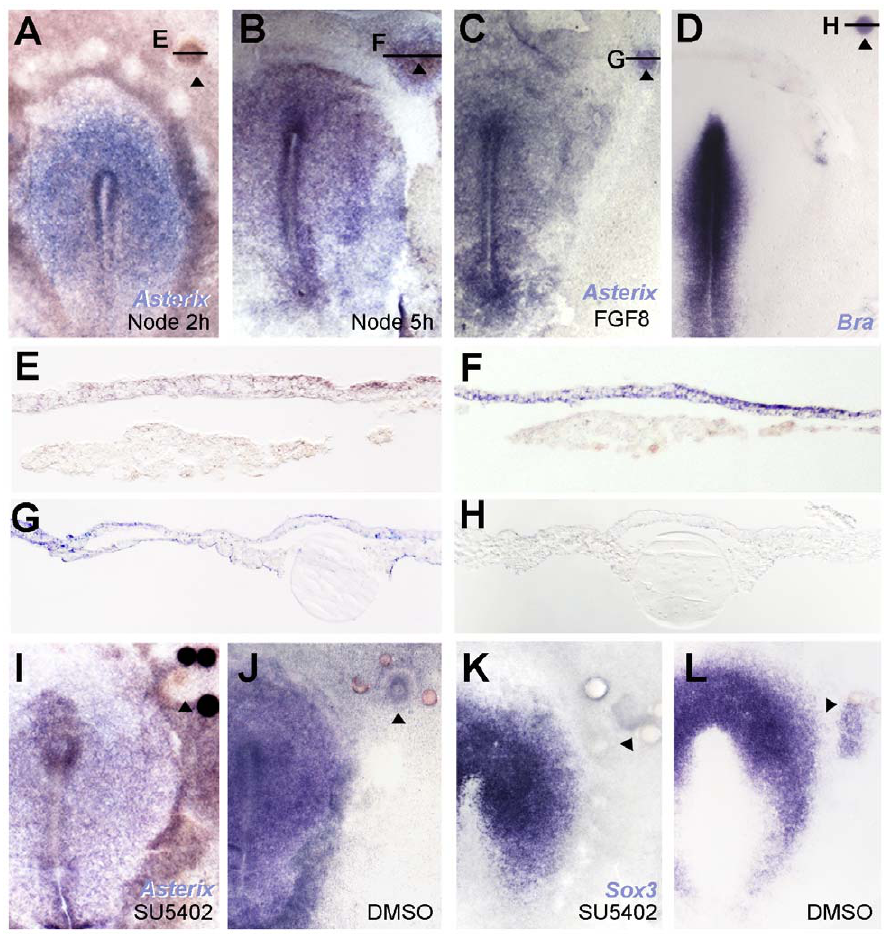
Figure 9. Regulation of Asterix by Hensen’s node and peptide factors. Grafts of Hensen’s node do not induce Asterix after 2 hours (A, E), but do induce it after 5 hours (B, F). This is mimicked by grafts of heparin beads soaked in FGF8, which induce Asterix (C, G) but not Brachyury (D, H). When a node is grafted together with beads soaked in the FGF inhibitor SU5402, Asterix induction is blocked (I), as is induction of the early pre-neural marker Sox3 (K). Grafts of the node together with the vehicle DMSO do not affect induction of either marker (J for Asterix , L for Sox3 ). Note that some probes attach non-specifically to some types of beads and to COS cell pellets (eg. panels H, I).